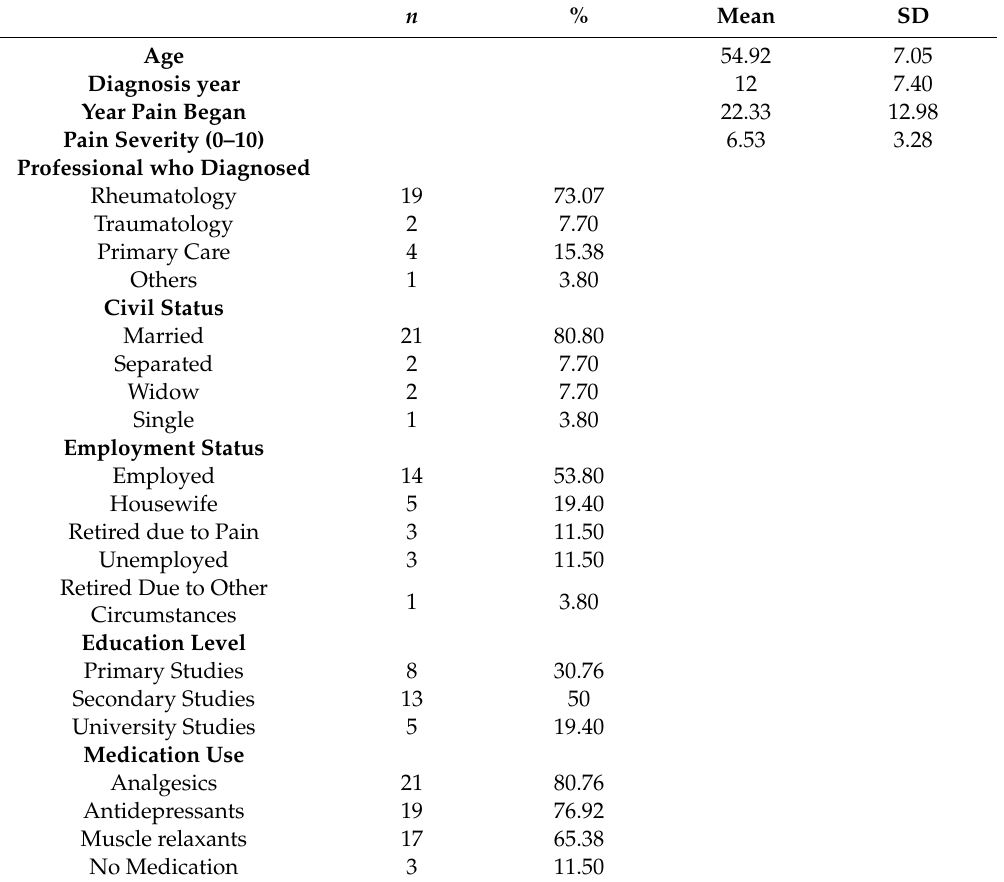
Table 2. Demographic and clinical features of the female participants with fibromyalgia.